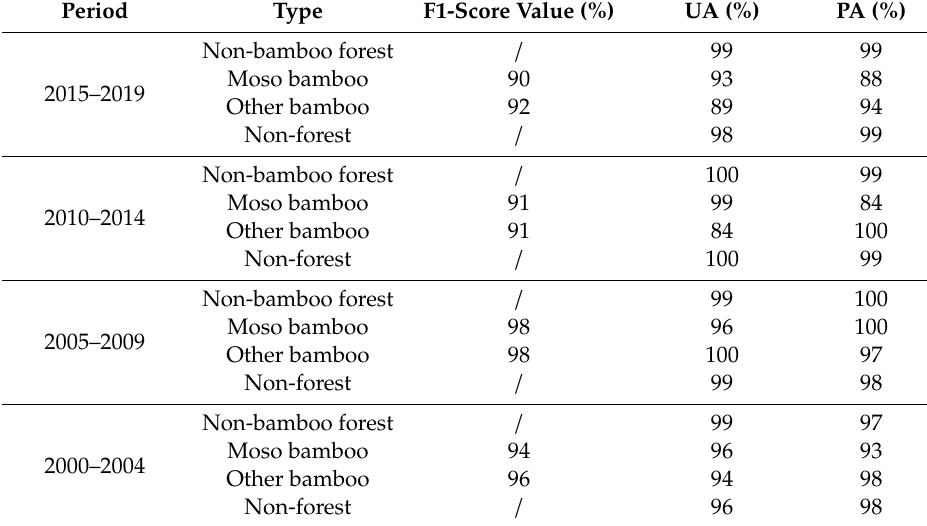
Table 2. Accuracy indices for the reclassified classes in the four periods. UA: user’s accuracy; PA: producer’s